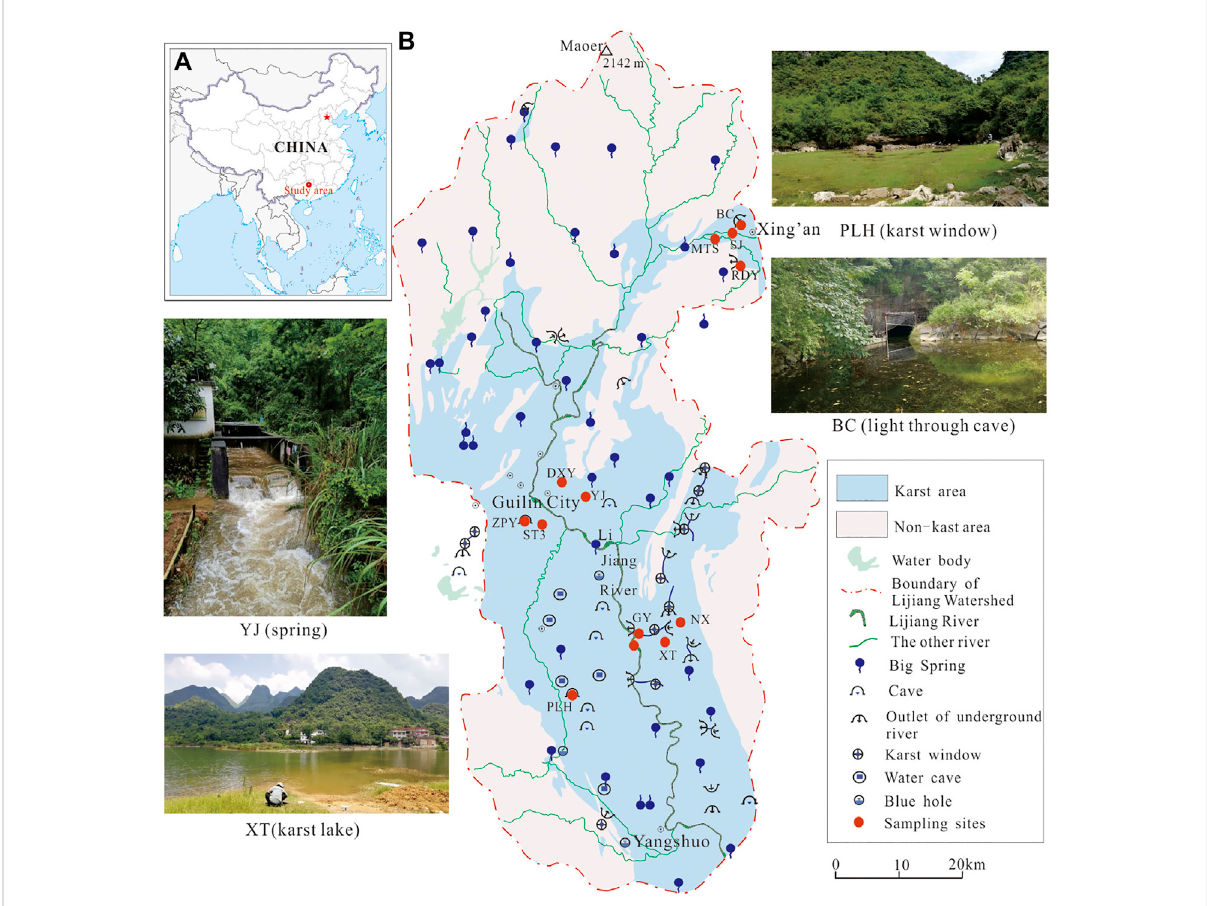
FIGURE 1 (A) Location of the study area; (B) The simple hydrogeology map of Lijiang River watershed. The red circles denote the locations of sampling sites. Four pictures show the features of typical wetlands in the